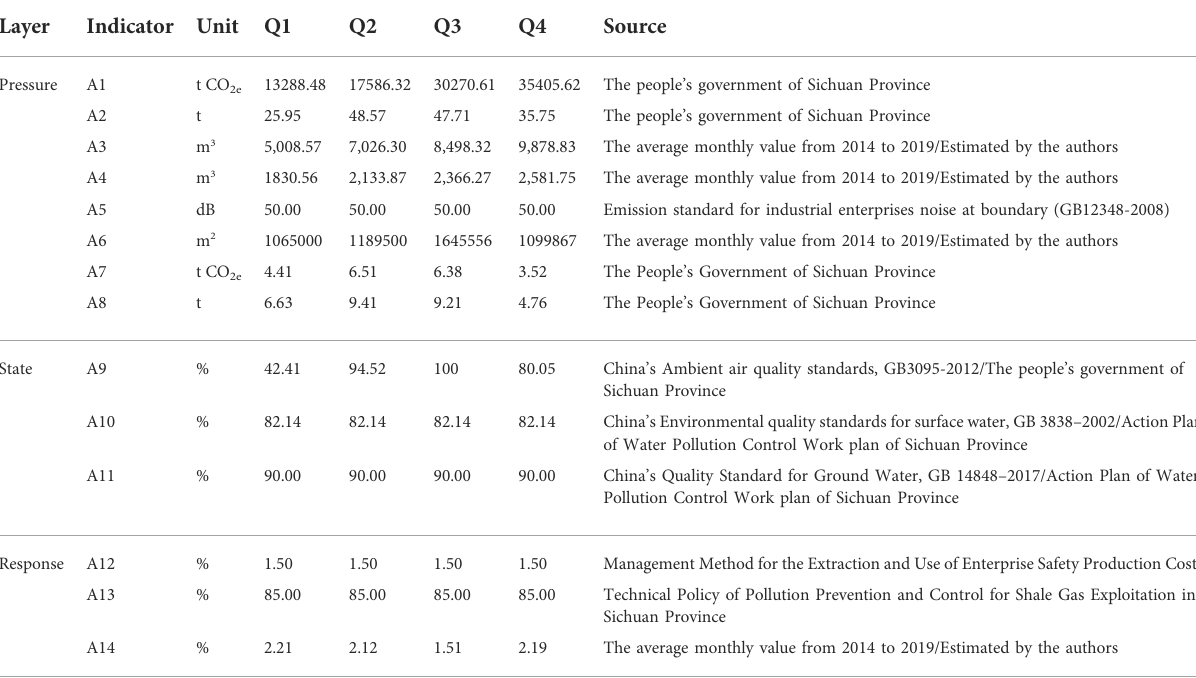
TABLE 3 The environment protection standards in Changning